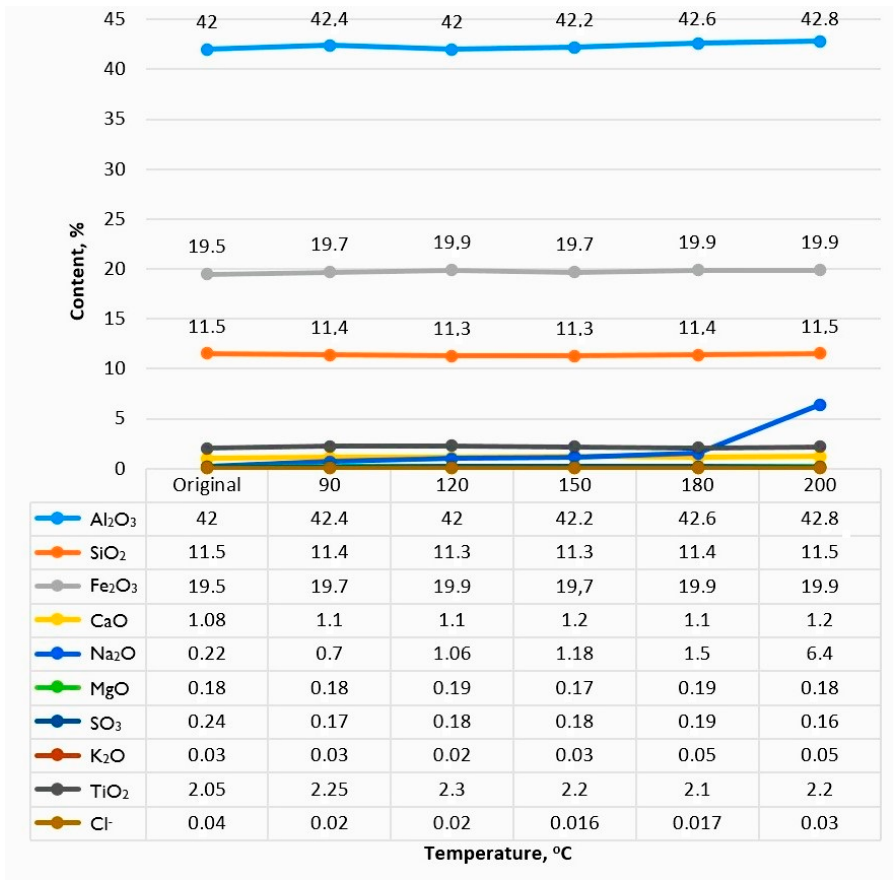
Figure 3. The chemical composition of bauxite samples depending on the activation temperature.